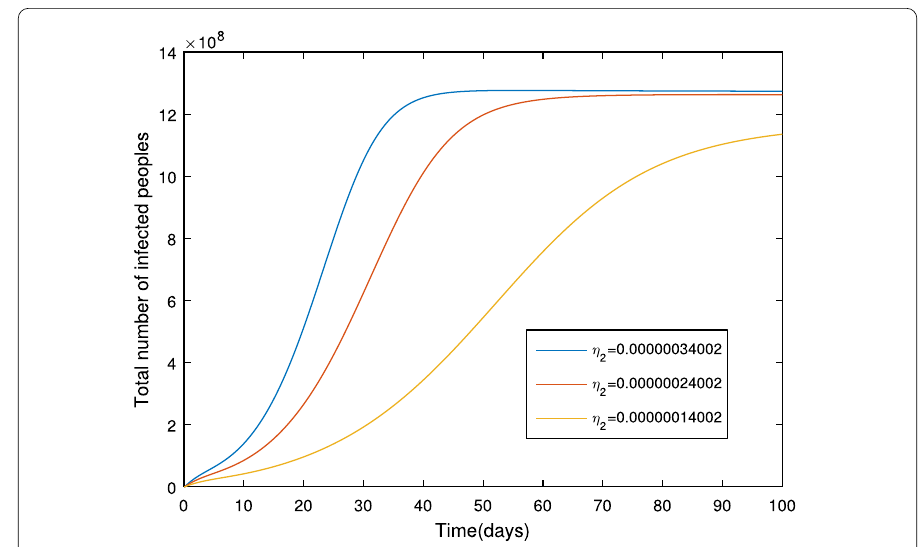
Figure 4 The total number of infected people for various values of η 2